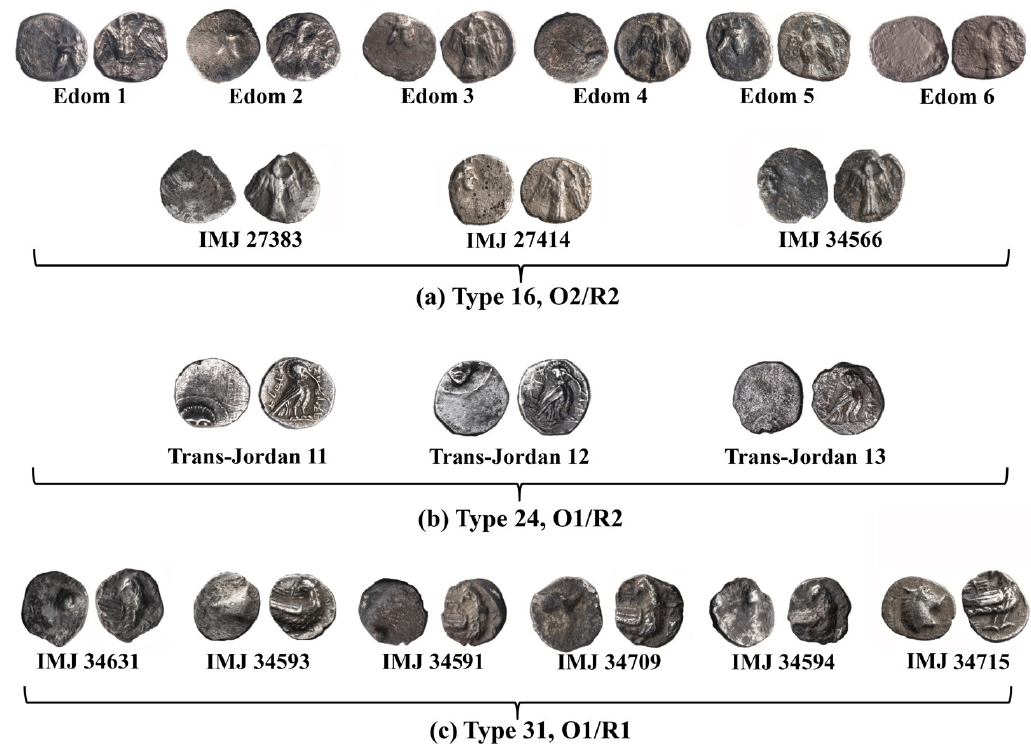
Figure 4. Yehud coins: ( a ) Type 16 O2/R2, ( b ) Type 24 O1/R2, and ( c ) Type 31 O1/R1 of the Yehud series.